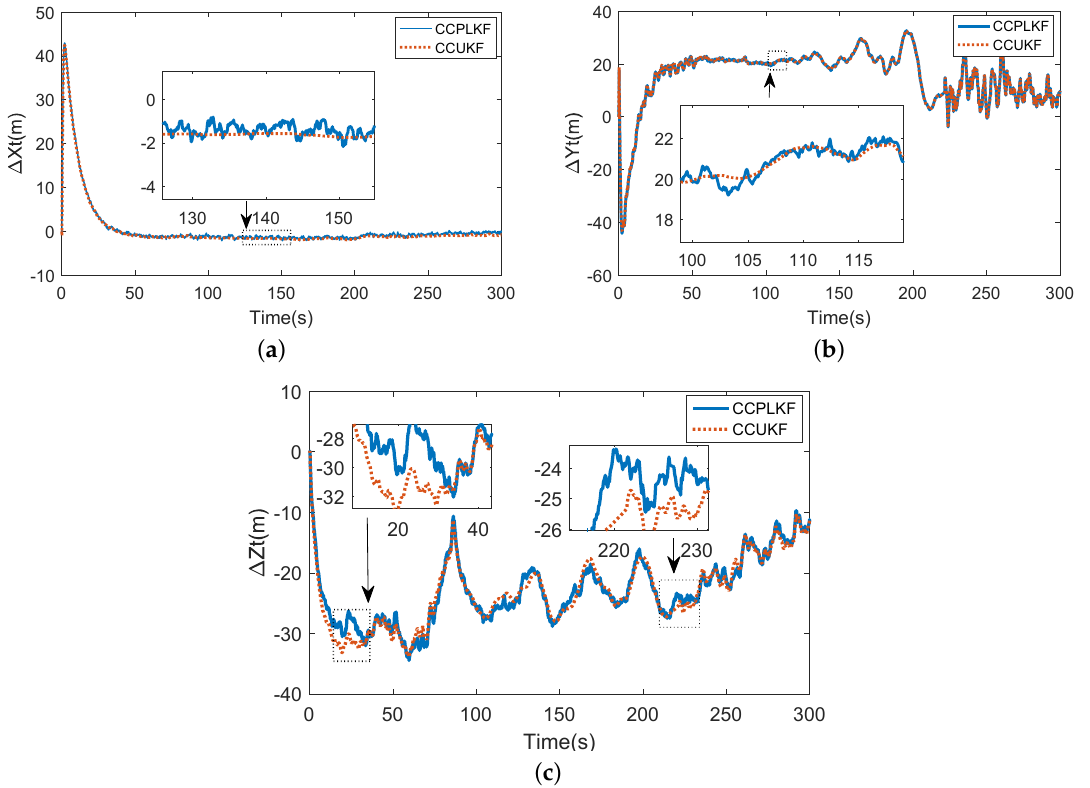
Figure 10. ( a ) Estimation Error of x coordinate of target; ( b ) Estimation Error of y coordinate of target. ( c ) Estimation Error of z coordinate of target. Table 2. RMSE of tracking